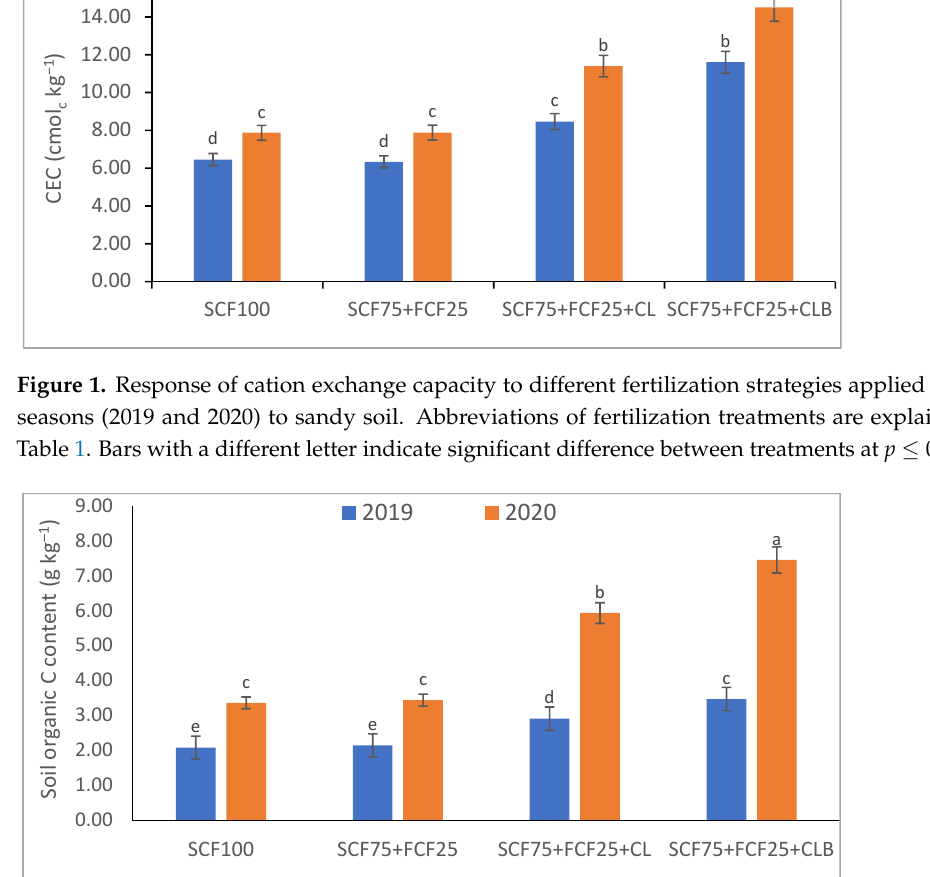
Figure 2. Response of soil organic C content to different fertilization strategies applied in two seasons (2019 and 2020) to sandy soil. Abbreviations of fertilization treatments are explained in Table 1. Bars with a different letter indicate significant difference between treatments at p ≤ 0.05.